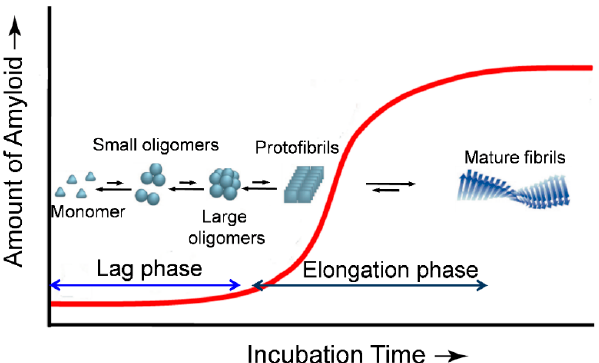
Figure 1. Schematic representation of a typical nucleated polymerization process of protein aggregation. Oligomeric nuclei are formed in the early lag phase stage, being a critical rate limiting step. In an elongation phase, addition of monomers and/or oligomers onto the nucleus allows formation of fibrils which is energetically favorable.